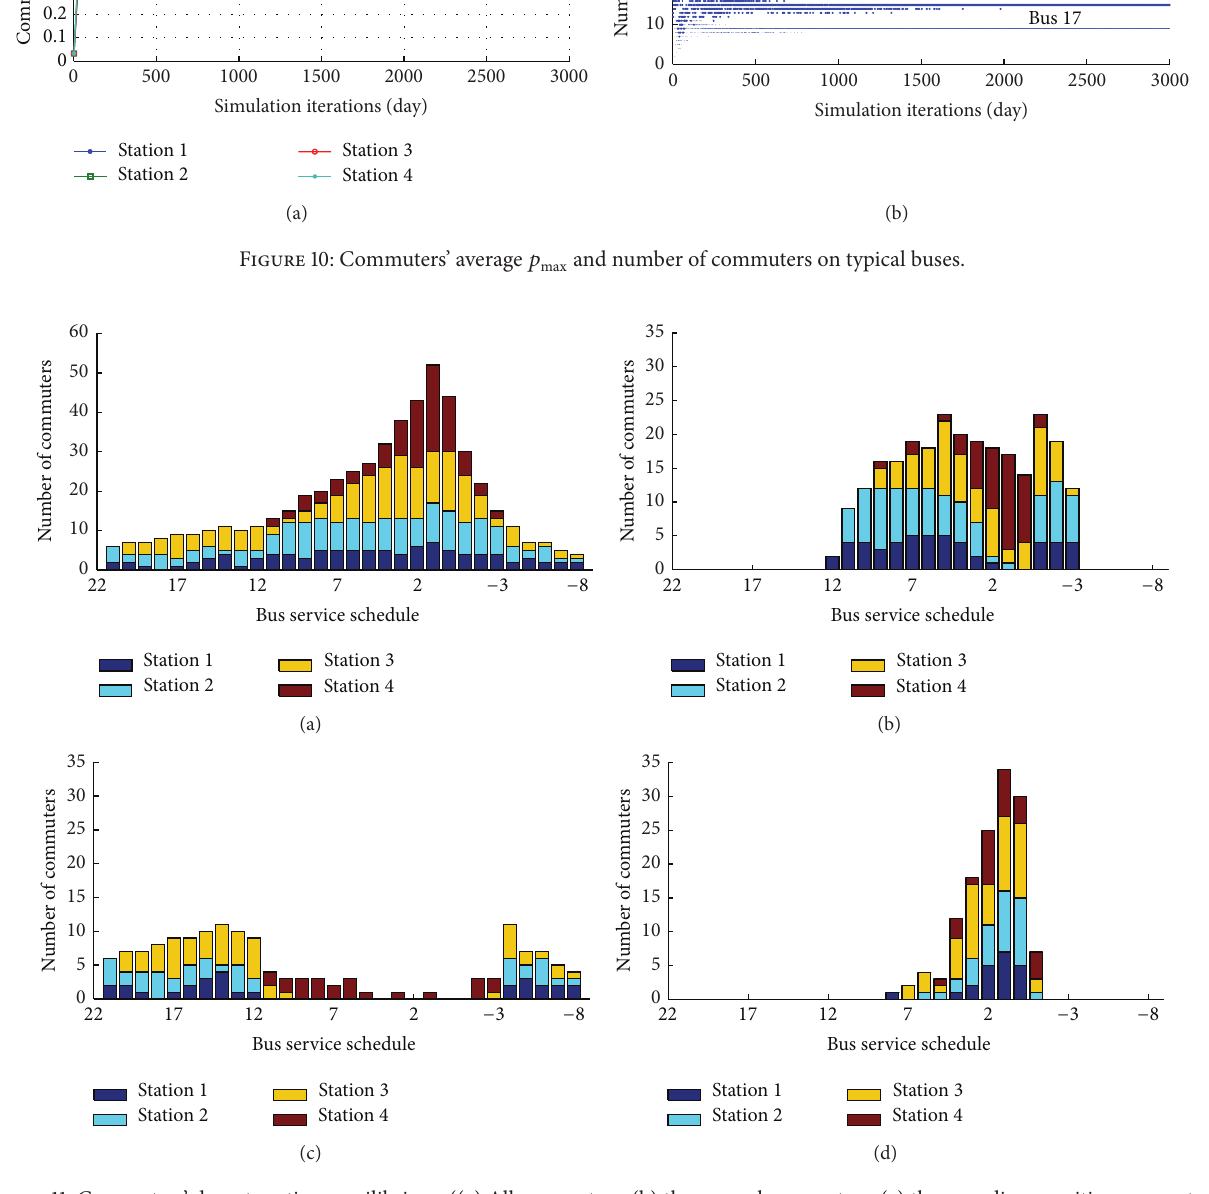
Figure 11: Commuters’ departure time equilibrium. ((a) All commuters, (b) the normal commuters, (c) the crowding-sensitive commuters, and (d) the crowding-insensitive